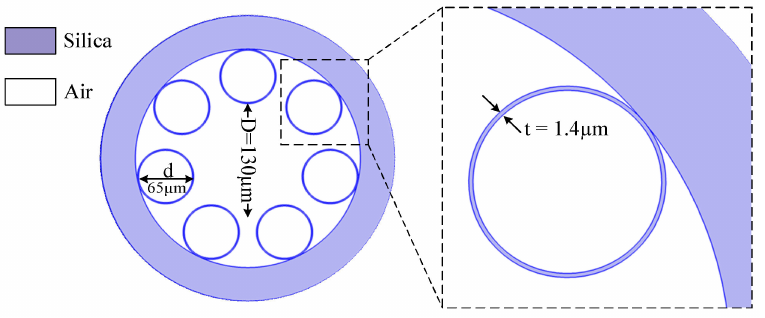
Figure 1. Cross section of the proposed HC-ARF to be applied in the photoacoustic